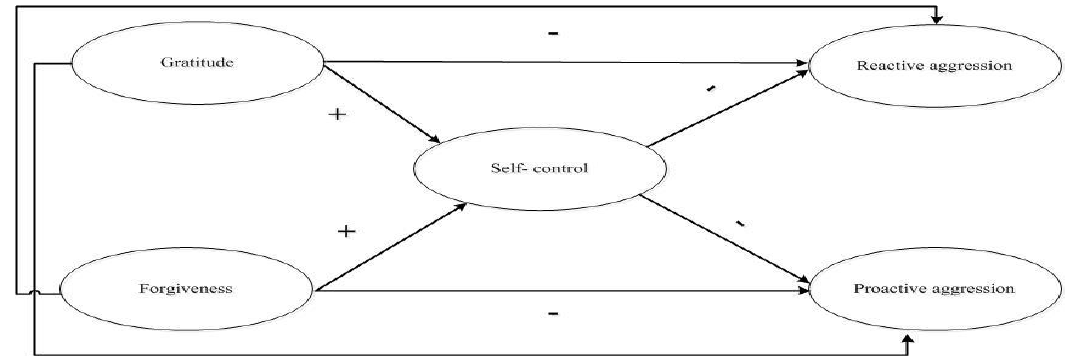
Figure 1. Theoretical model of the relations between gratitude, self-control, forgiveness, reactive and proactive aggression in adolescents.